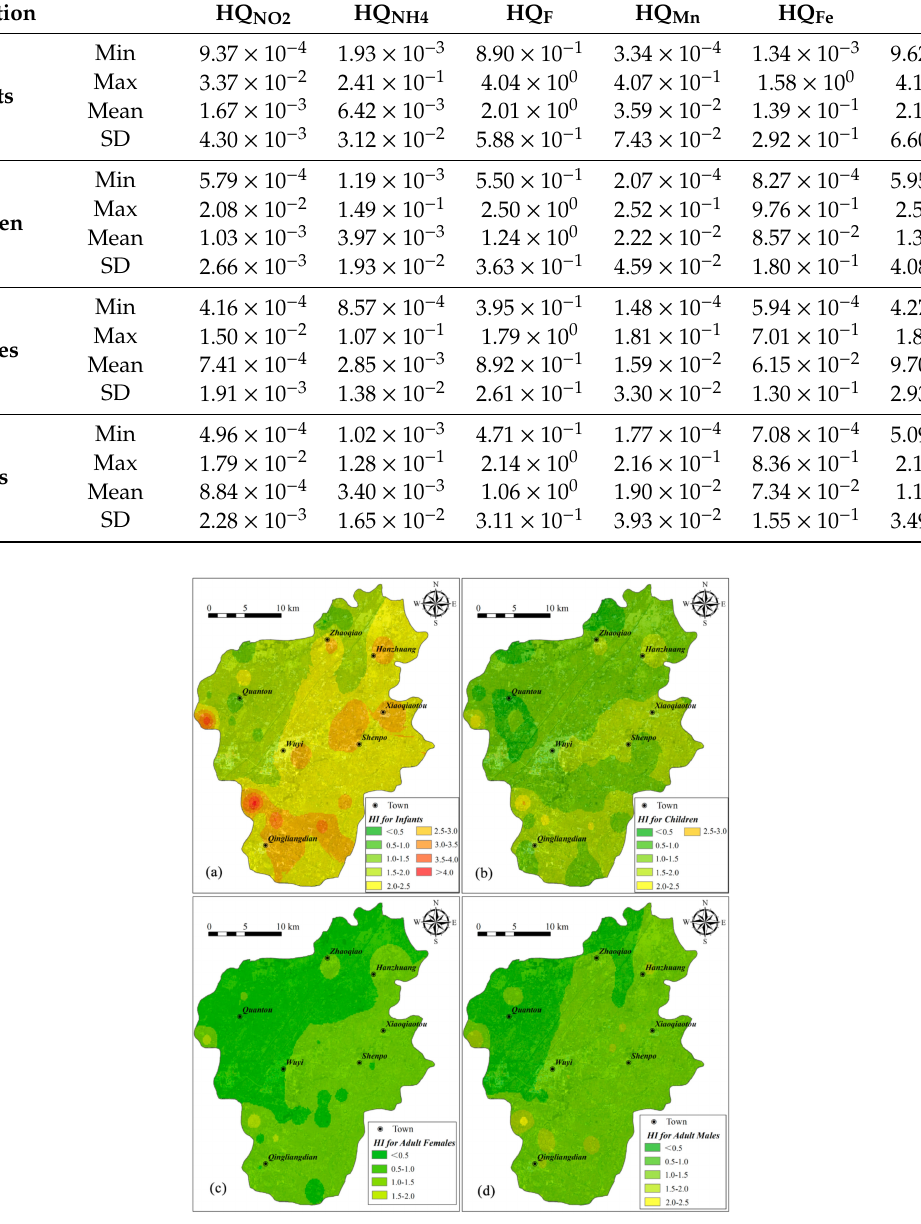
Figure 7. Spatial distribution of the overall potential noncarcinogenic health risks through drinking pathway for ( a ) infants, ( b ) children, ( c ) adult females, and ( d ) adult